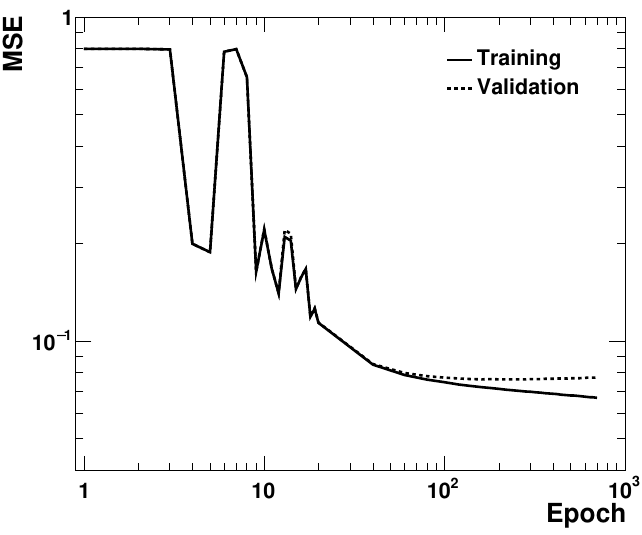
Figure 2. Variation of mean squared error (MSE) vs. the number of epochs for the training and validation RMM data. The MSE for training and validation samples are similar for a small number of epochs. The large oscillations in MSE are due to finding the most optimal weights in the presence of empty RMM cells (which are similar for the validation and training sample). The deviation between the training and validation sample after 100 epochs indicates over-training.